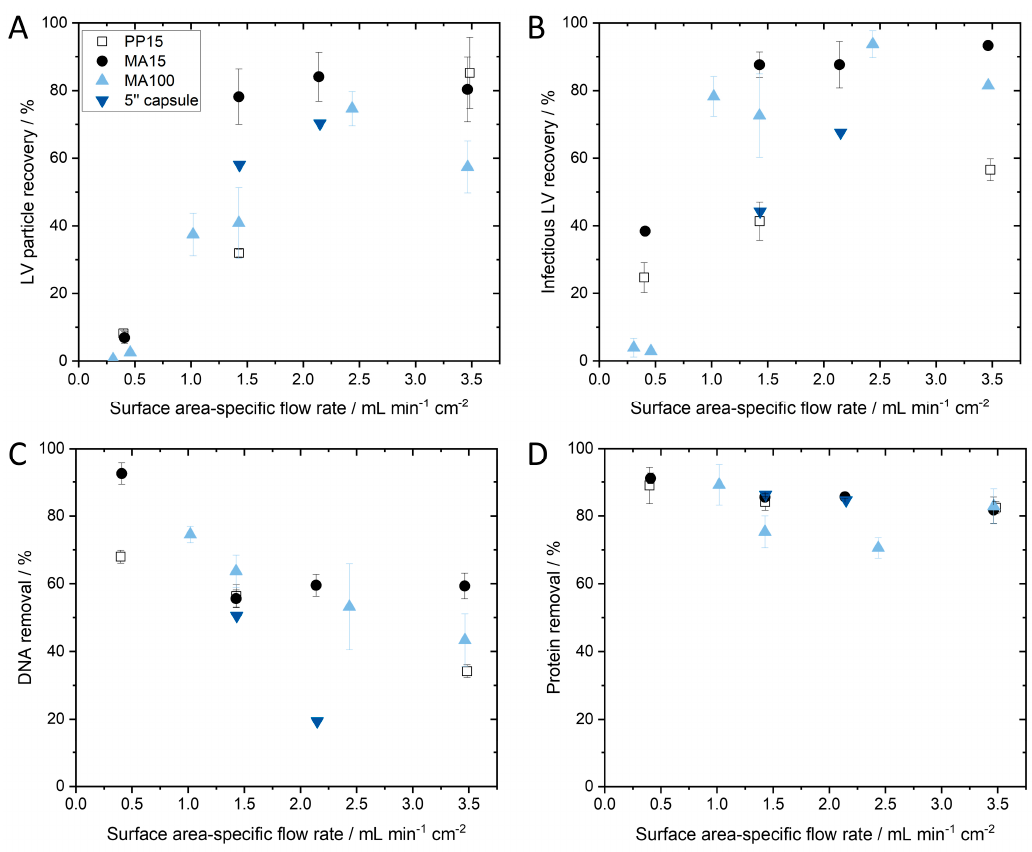
Figure 6. ( A ) Particle and ( B ) infectious LV recovery and ( C ) dsDNA and ( D ) protein removal in SXC experiments plotted against different surface area-specific flow rates for different module sizes. Replicates for each device and flow rate are as follows: PP15, N = 3 for all flow rates; MA15, N = 3 for all flow rates; MA100, for 1.43 mL·min − 1 ·cm − 2 N = 11, for all other flow rates N = 3; 5 ′′ capsule, N = 1.